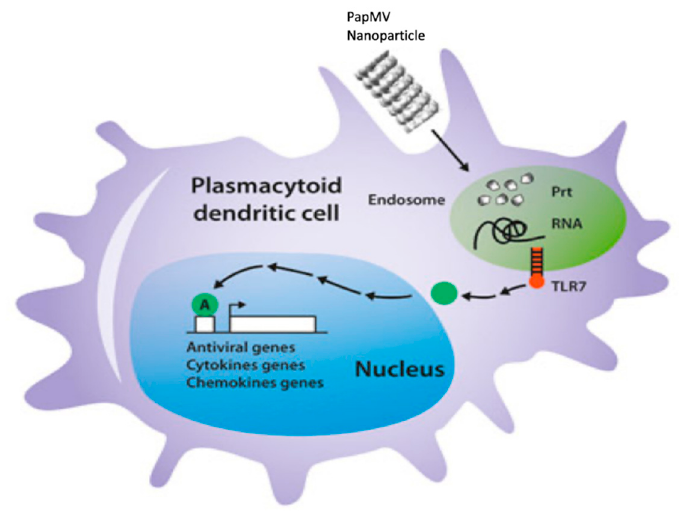
Figure 7. Schematic representation of the mechanism of activation of Toll-like receptor 7 (TLT7) by a PapMV nanoparticle. In brief, PapMV nanoparticles are internalized into immune phagocytes, such as plasmacytoid dendritic cells (pDCs) or macrophages, and reach the endosomal compartment, where they become disassembled because of the harsh conditions in the endosome. The single- stranded RNA (ssRNA) contained in the nanoparticle is liberated and activates TLR7, triggering an antiviral immune